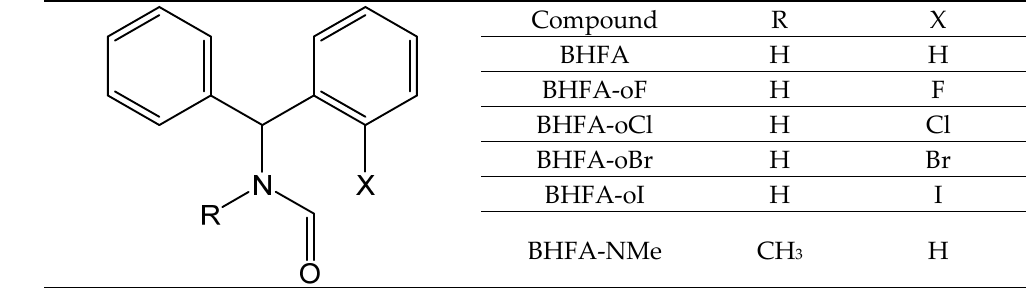
Scheme 1. Structures of the investigated